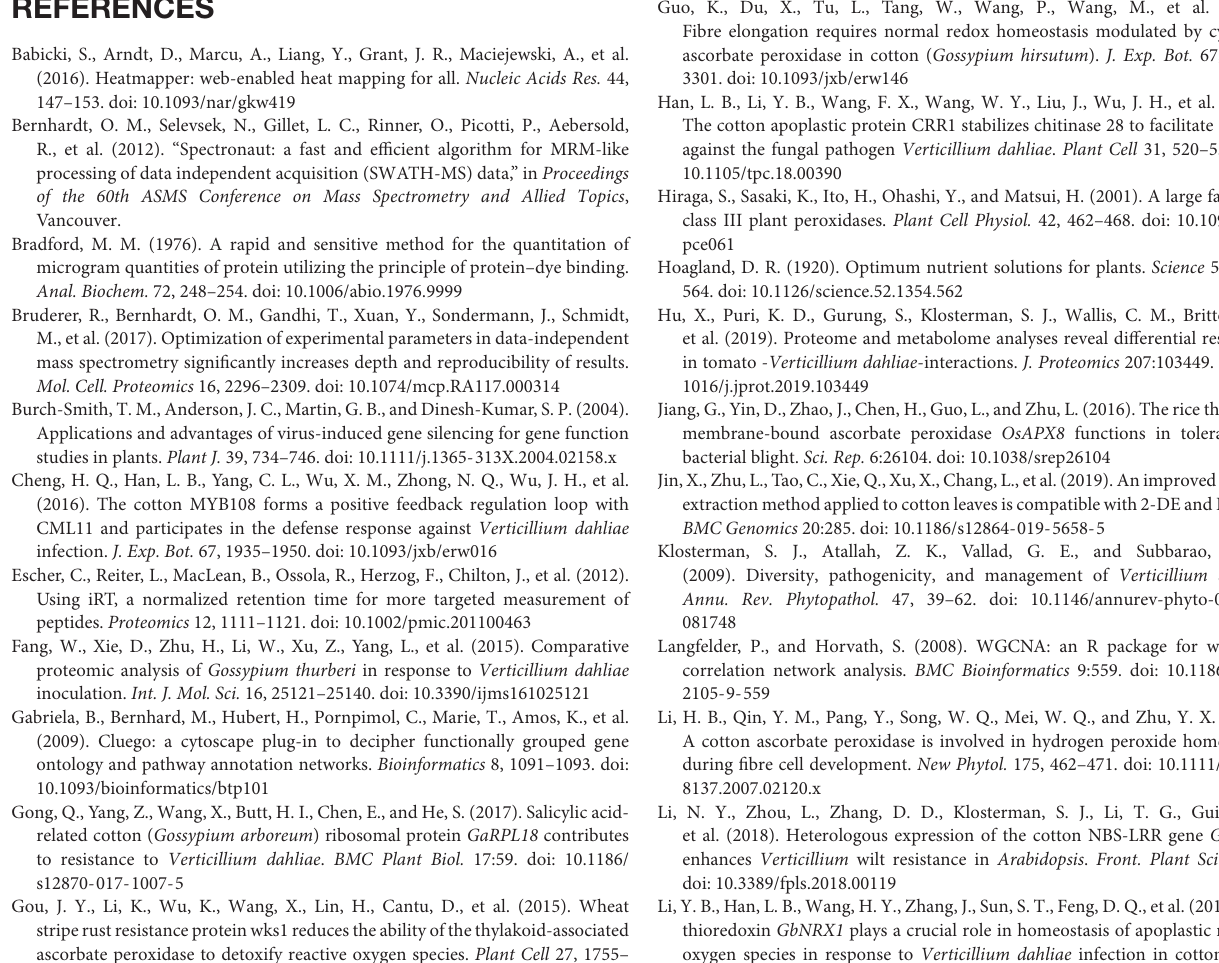
Supplementary Figure 11 | Heatmap of transcriptional expression levels of all G. barbadense APX genes deduced from public transcriptome data of V. dahlia- treated roots. The transcriptome data of G. barbadense roots after V. dahliae treatment were obtained from the public online database at NCBI